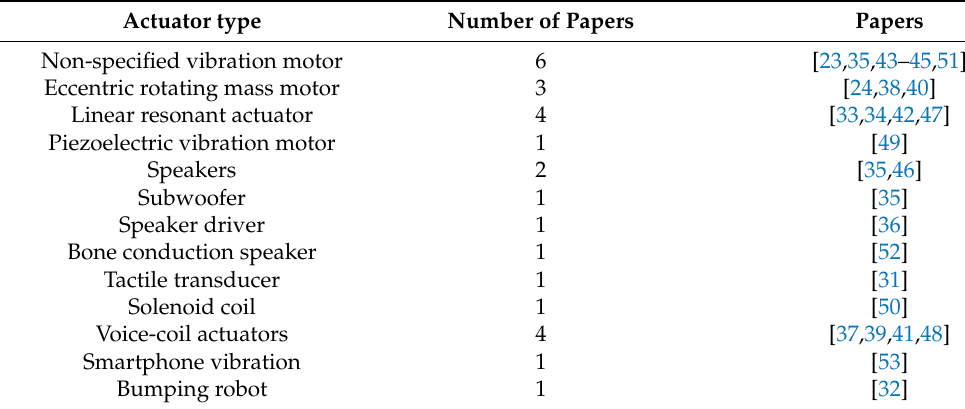
Table 6. Papers divided by the type of actuator used to generate haptic stimuli.